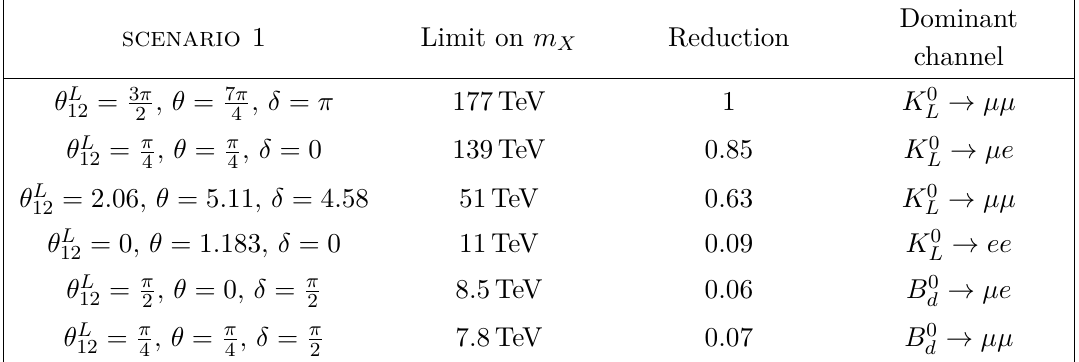
Table 8 . Limits obtained for the gauge leptoquark mass X µ for different choices of the mixing angles appearing in eq. (3.3) with an exact helicity suppression where we have chosen K de The decay process from which the dominant limit arises is also listed as well as the percentage reduction from the non-helicity suppressed scenario given in table 4. In some cases only a small reduction in the mass limits occurs, this is a result of the Kaon decay channels being helicitiy suppressed as a result of the structure of the mixing matrices instead of due to a chiral coupling of X µ . Only the benchmark scenarios which initially had dominant decay channels arising from B d or B s experience a significant reduction in their limits as they were initially not helicity suppressed.